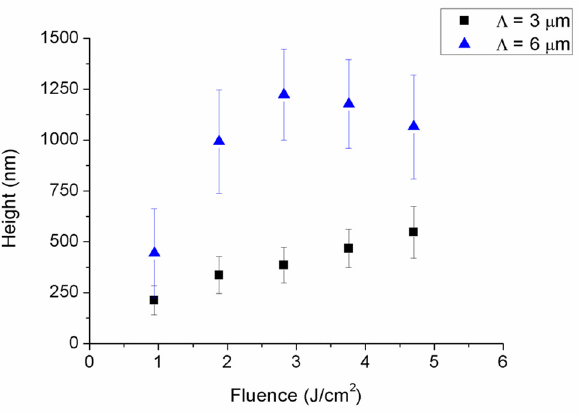
Figure 4. Height of DLIP structures as a function of delivered cumulated laser fluence.